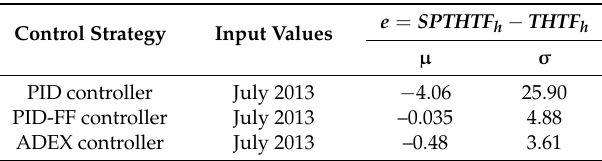
Figure 11. Results obtained for the different algorithms using real data, July 2013. DNI and HTF temperature at the solar field input ( a ); HTF temperature for the PID-FF ( b ); PID ( c ); and ADEX ( d ) regulators. Table 5. Comparison of results (July 2013).